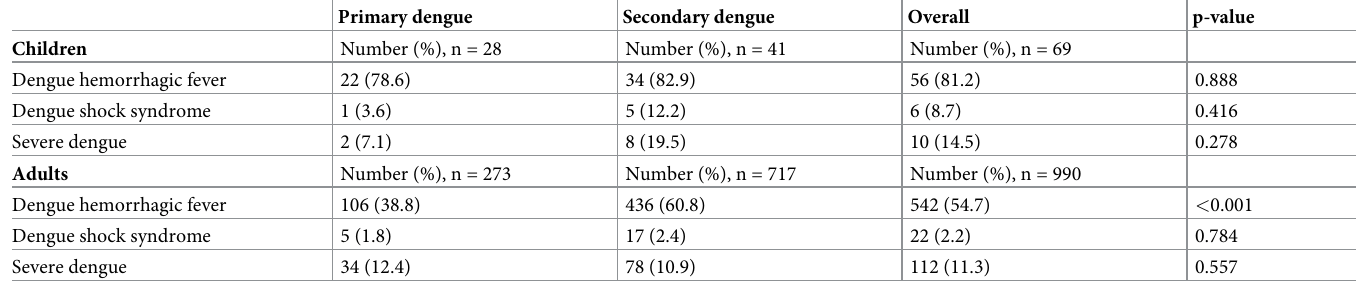
Table 4. Primary clinical outcomes among children and adults with primary versus secondary dengue, Southern Province, Sri Lanka, 2017–2018. Primary